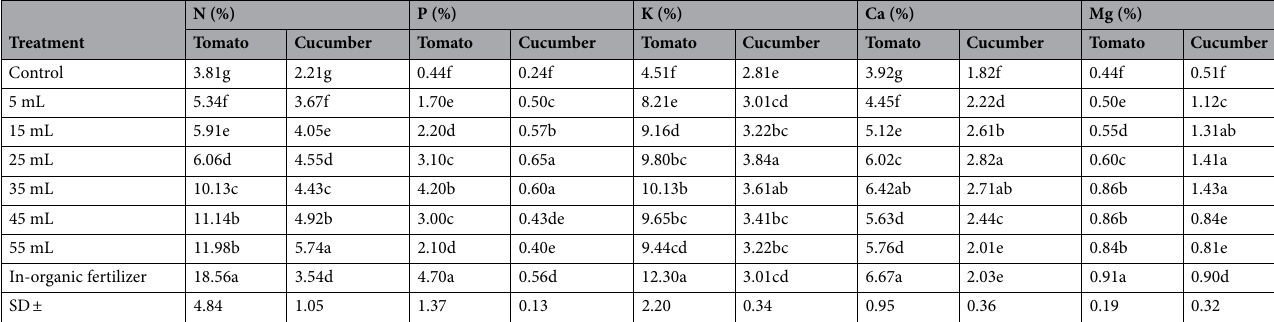
Table 2. Effect of organic and in-organic fertilizers of leaf nutrient concentration of tomato and cucumber under soilless medium (means from sites A & B). Values followed by similar letters under the same column are not significantly different at p = 0.05 according to Duncan’s multiple range test.